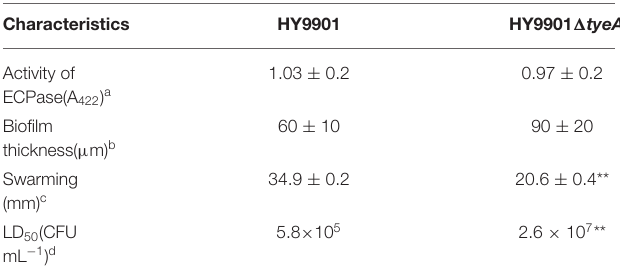
TABLE 4 | Comparison of biological characteristics between HY9901 and HY9901 1 tyeA .